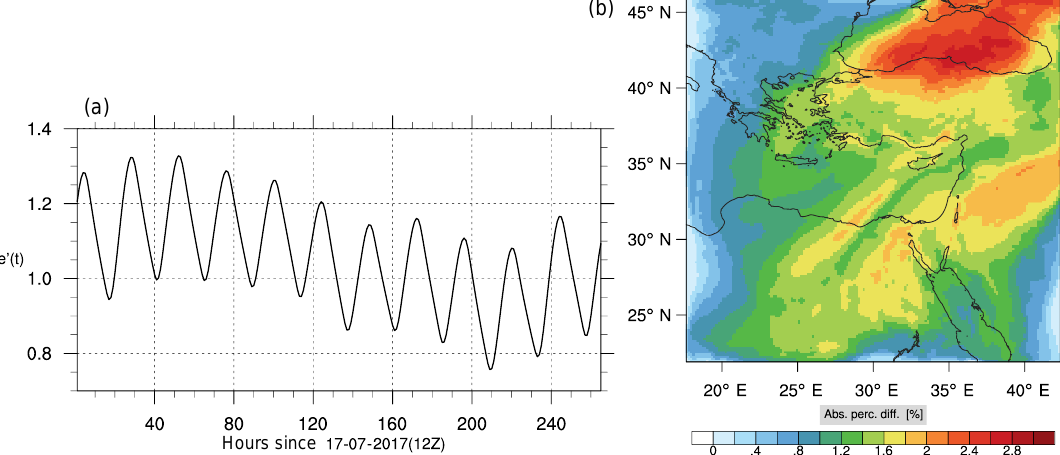
Figure 16. (a) The volume-weighted average of the absolute percentage difference between the full and skeletal mechanisms, e (cid:48) (t) , for the carbon monoxide mixing ratio. (b) The spatial distribution of the absolute percentage difference between the reduced and the full mechanisms, with respect to the full mechanism, for the CO mixing ratio when e (cid:48) (t) is